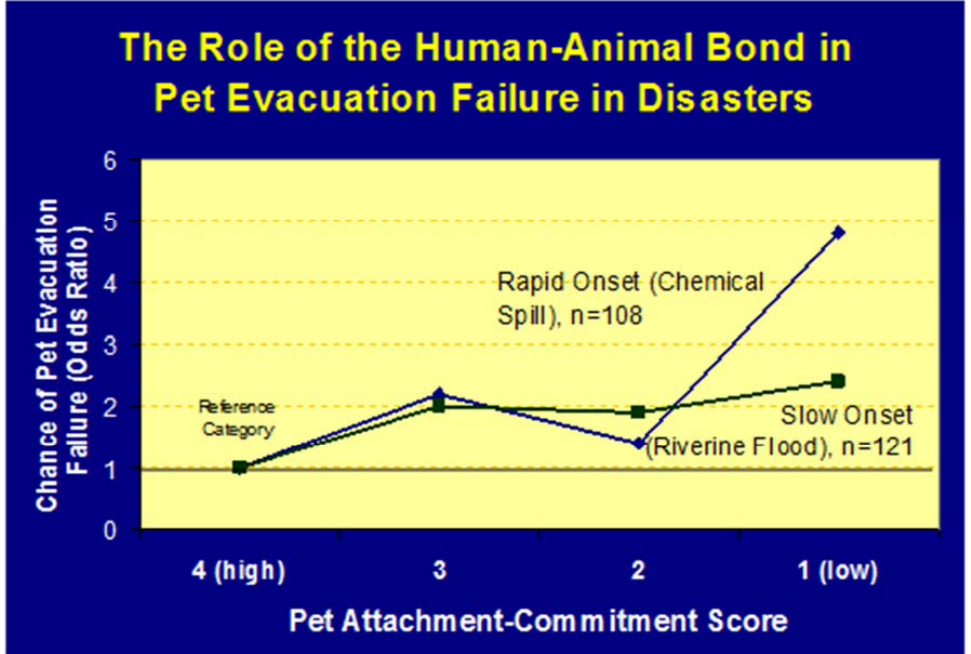
Figure 5. Chart showing an inverse correlation between the strength of pet owners’ bond with their pets and the likelihood that they will evacuate their pet in both slow and rapid onset disasters [28]. onset disasters